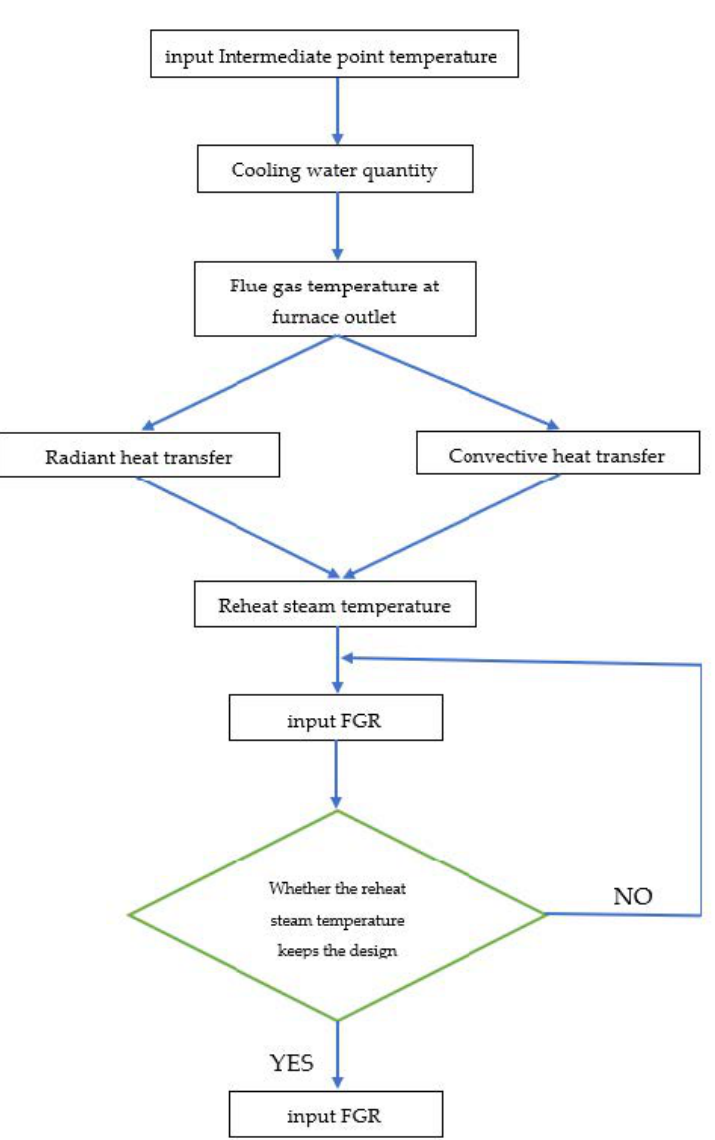
Figure 8. Flowchart of the influence of the intermediate point temperature on FGR.